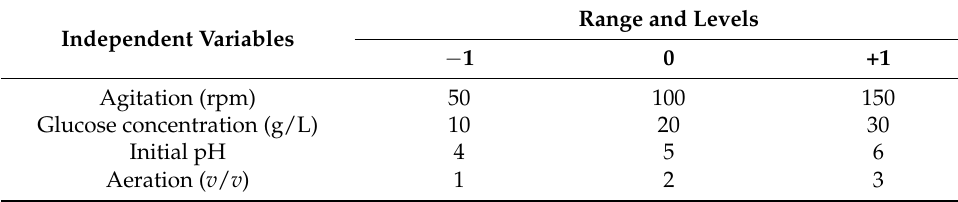
Table 1. Experimental range and levels of independent